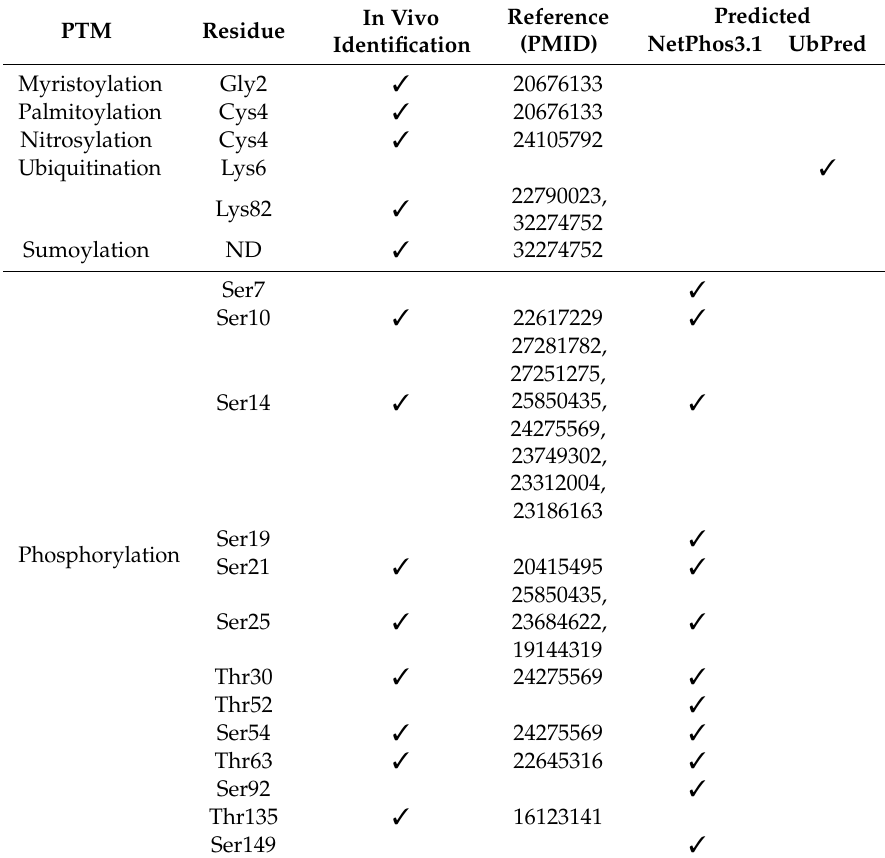
Table 1. Post-translational modifications experimentally validated or identified by prediction servers in human and mouse RNF11